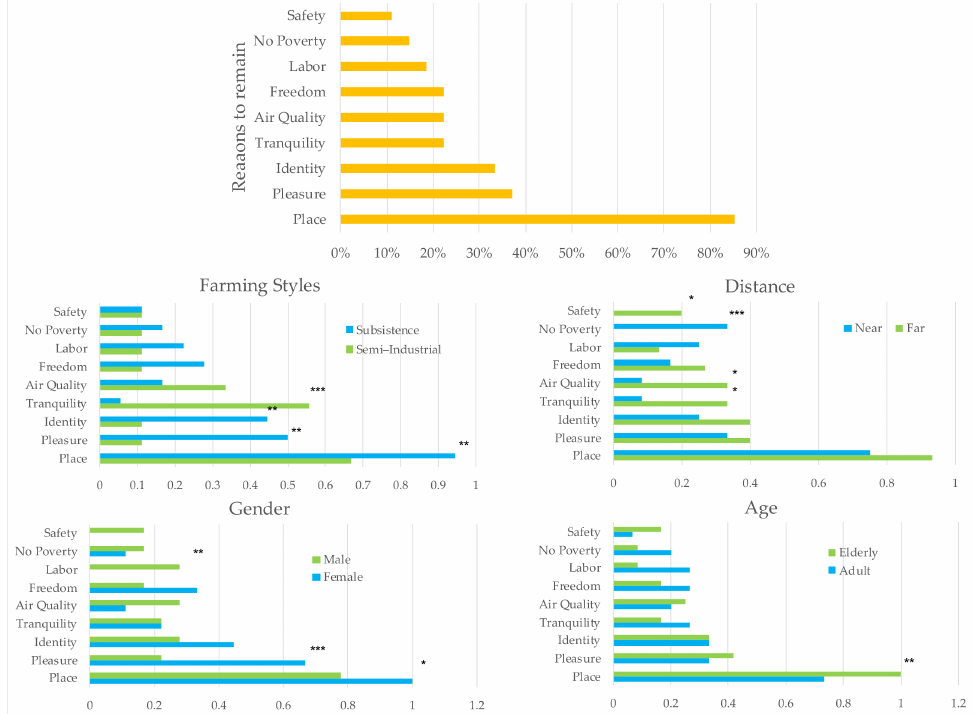
Figure 6. Farmer’s motivations to remaining in the CCLC. Signification of codes: 0.05, ‘***’; 0.1, ‘**’; 0.15,